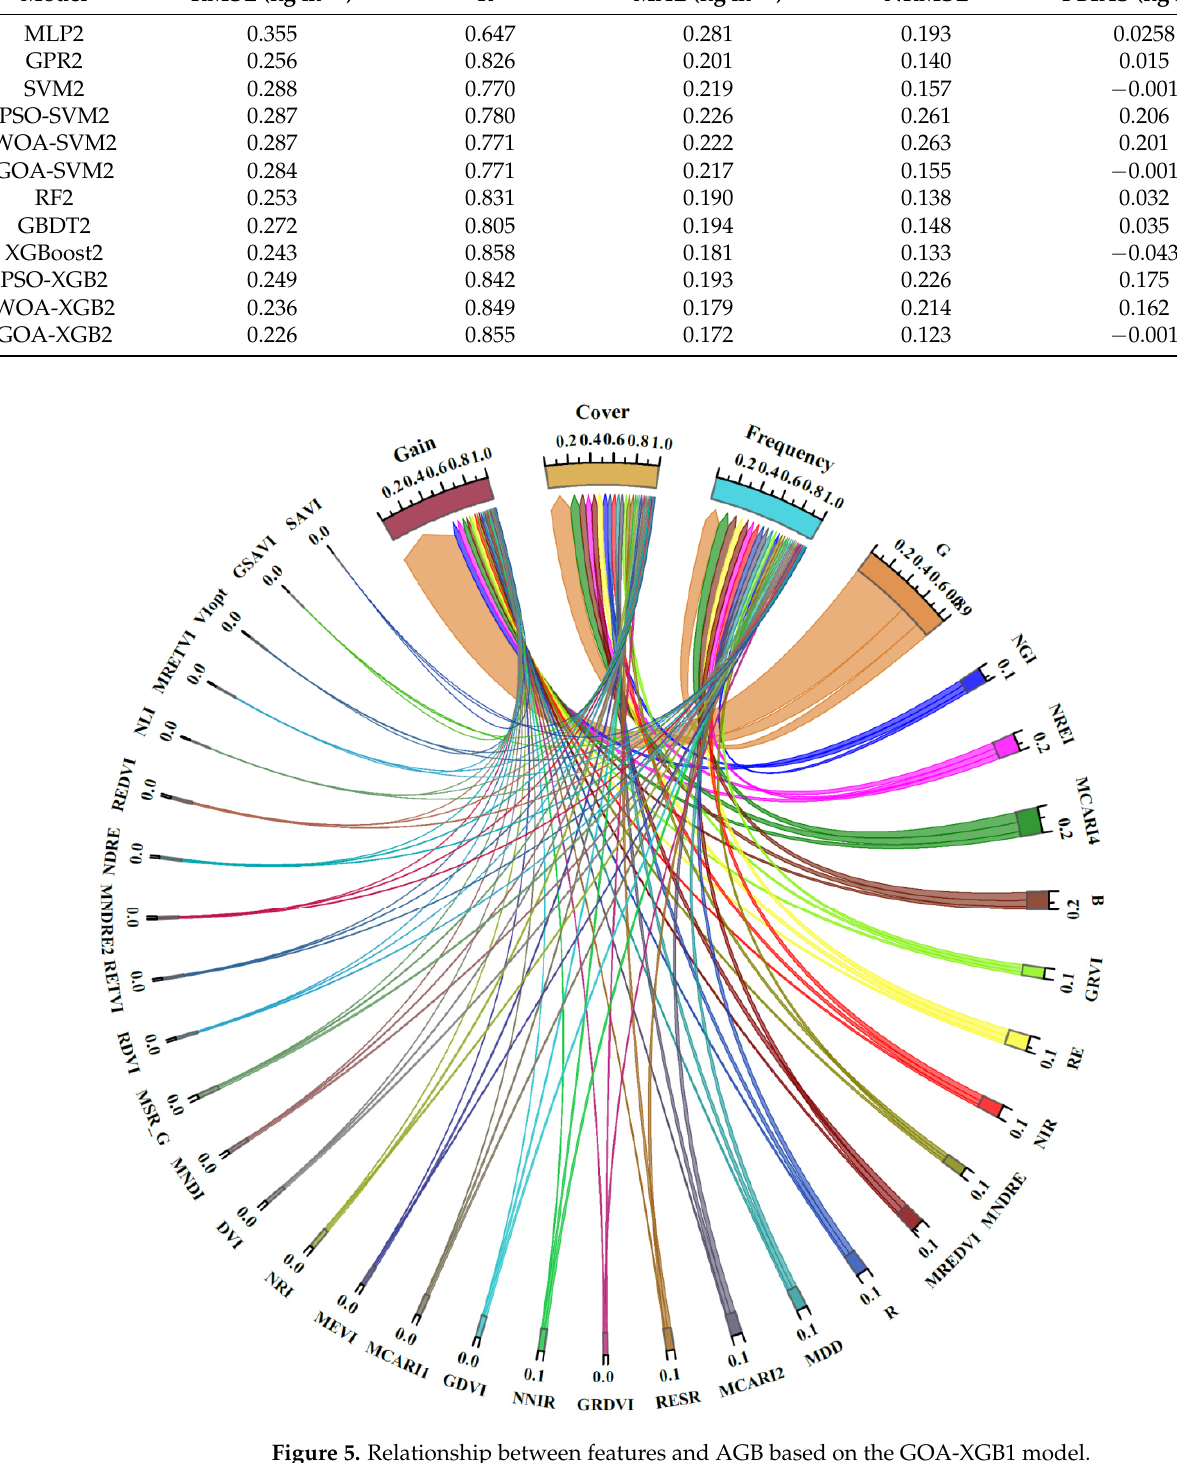
Figure 5. Relationship between features and AGB based on the GOA-XGB1 model. Table 7. Statistics indicators of twelve ML models with optimized features as input.